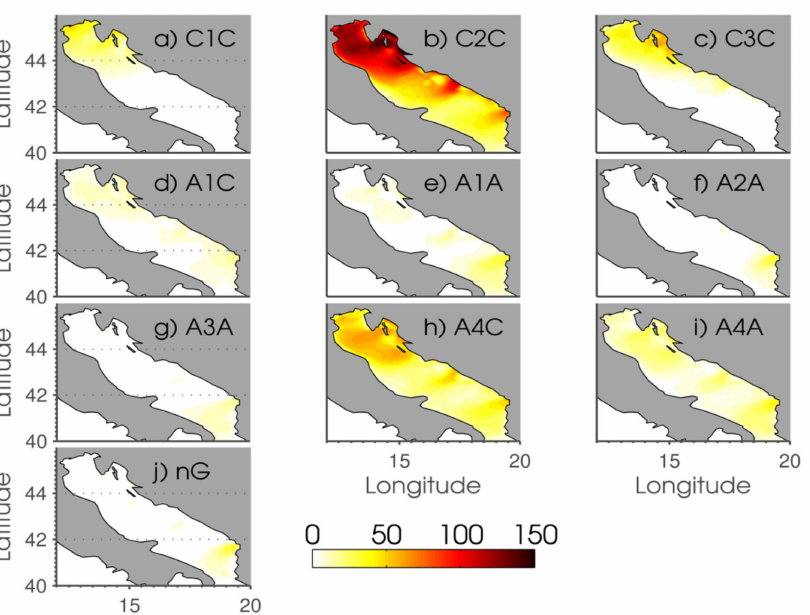
Figure 4. WT responsible for Bora formation in the near-present day (1971–2000) in DJF; ( a ) front sector of deep cyclone (C1C), ( b ) upper sector of deep cyclone (C2C), ( c ) back sector of deep cyclone (C3C), ( d ) front sector of shallow anticyclone (A1C), ( e ) front sector of deep anticyclone (A1A), ( f ) upper sector of deep anticyclone (A2A), ( g ) back sector of deep anticyclone (A3A), ( h ) lower sector of shallow anticyclone (A4C), ( i ) lower sector of deep anticyclone (A4A), ( j ) quasi-non-gradient field